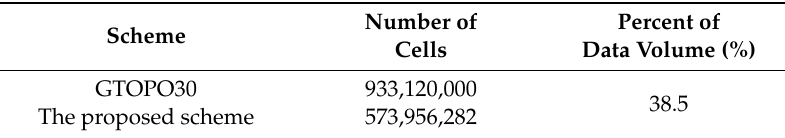
Table 3. Comparison of data volume for di ff erent